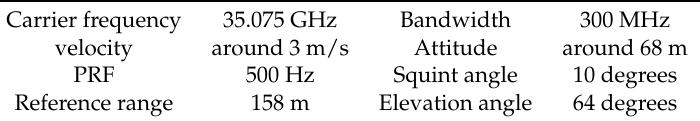
Table 1. UAVSAR Parameters.